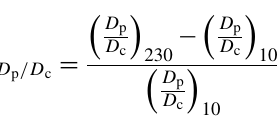
Figure 3. The increase in the D p /D c ratio and calculated E ab (IR D ) for BC-containing particles with and IR E p /D c ab PM 1 concentration increasing from 10 to 230µgm − 3 . The cal- culated IR D and IR E values were determined based on p /D c ab Eqs. (13) and (14). The measured IR D and IR E values were p /D c ab obtained from SP2